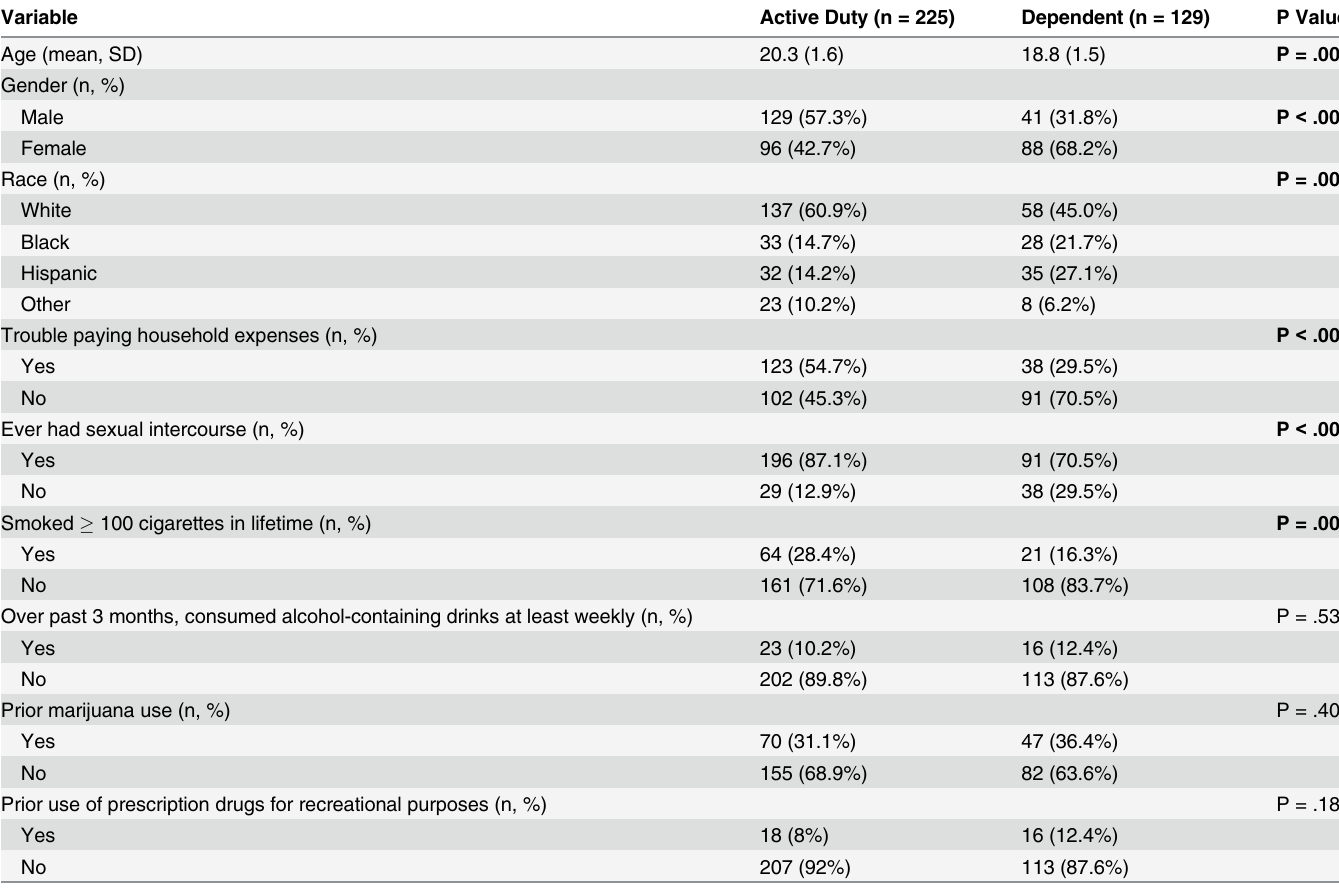
Table 3. Participant characteristics and risk behaviors among patients aged 17 – 23 who presented to military adolescent clinics (n =